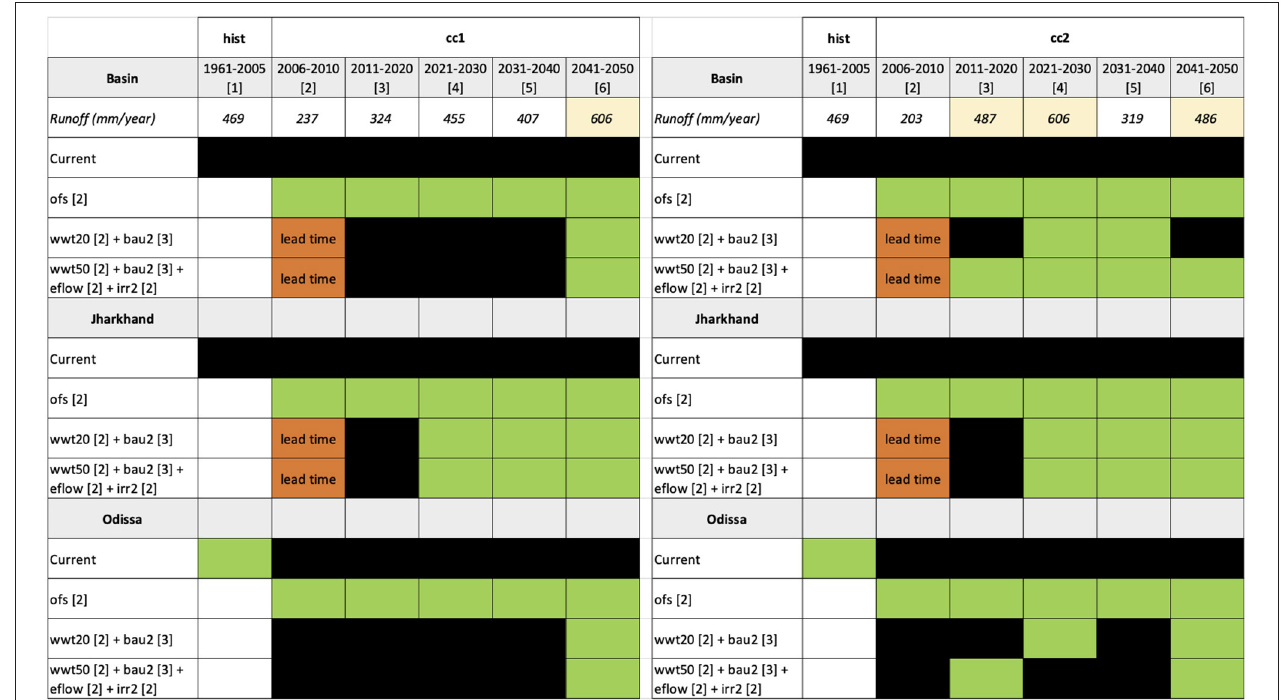
FIGURE 5 | Examples of ATPs results and associated expected timing (black) for actions, alone or in combination. Results are presented at the basin scale and the states scale. Absence of failure are displayed in green. Two future scenarios are considered: under increased global socioeconomic inequalities and drier climate conditions ( cc1 ) and similar global socioeconomic conditions and wetter climate ( cc2 ). The mean annual runoff is provided under both future conditions. Highlighted in yellow are runoff conditions for which some actions did not fail. Numbers in brackets = time range for each transient scenario. Notations are as follows: hist , current situation; ofs , on-farm water storages; wwt20 , treatment of 20% of D&I effluents; wwt50 , treatment of 50% of D&I effluents; irr2 , irrigation developments associated with the completion of ongoing and proposed dams; eflow , environmental flows; bau2 , implementation of proposed dams.